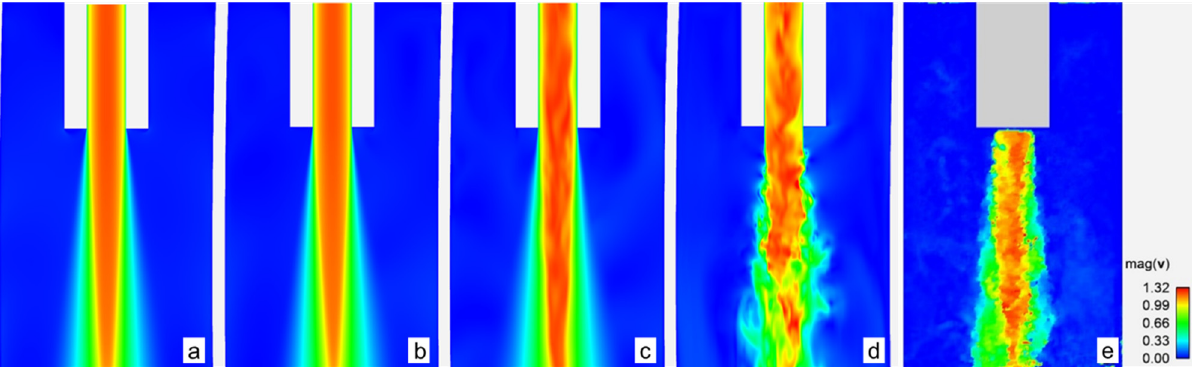
Figure 4. Contours of velocity magnitude in the x-y plane at z = 0 (middle of the SEN) for A1 ( a ), A2 ( b ), A3 ( c ), A4 ( d ), and experiment ( e ).